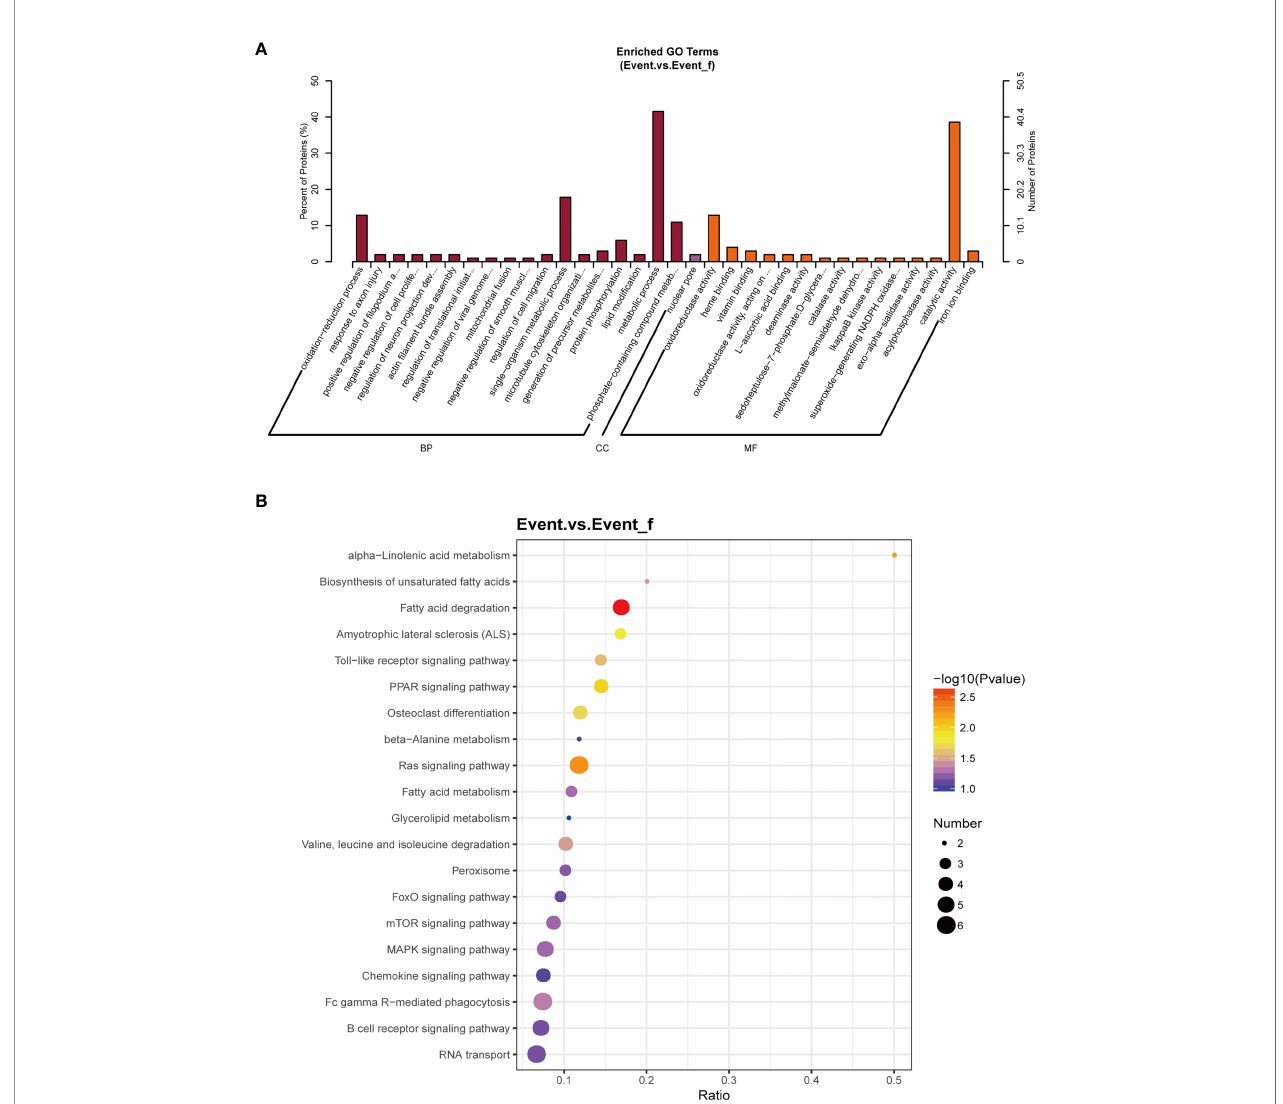
FIGURE 5 | The biological functions of all differentially expressed proteins (DEPs). (A) Gene Ontology (GO) enrichment analysis of the DEPs. (B) Kyoto Encyclopedia of Genes and Genomes (KEGG) enrichment analysis of the DEPs. The main signal pathways the DEPs involved in including pathways related to lipid metabolism. BP, biological process; CC, cellular component; Event_f, event free; MF, molecular